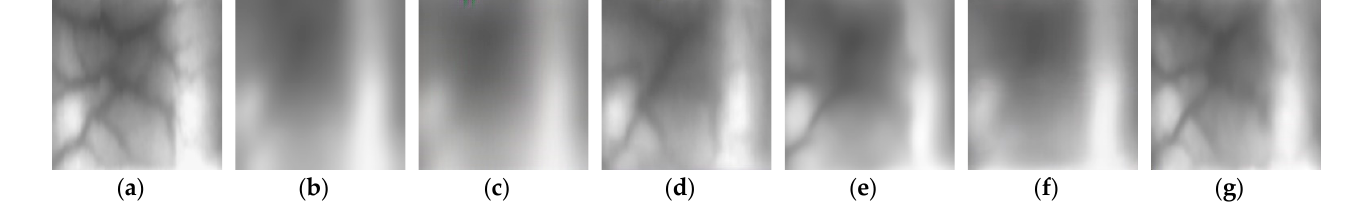
Figure 26. Examples of restored PolyU-DB finger-vein images using state-of-the-art methods and the proposed RMOBF-Net (motion blur with Gaussian blur filter of 19 × 19): ( a ) original image, ( b ) blurred image and images restored by ( c ) DeblurGAN, ( d ) DeblurGANv2, ( e ) SRN-DeblurNet, ( f ) MPRNet, and ( g ) RMOBF-Net. Table 7. Comparisons of motion and optical blur restoration performance of PolyU-DB by state-of- the-art methods and proposed RMOBF-Net (11 × 11, 15 × 15, and 19 × 19 mean the size of Gaussian blur filter).